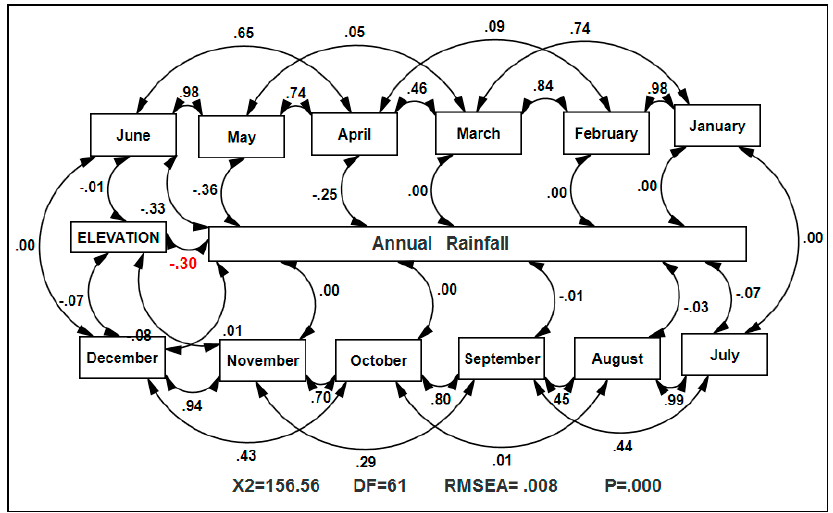
Figure 8. The correlation between the monthly temperatures, elevation and annual rainfall. Figure 8